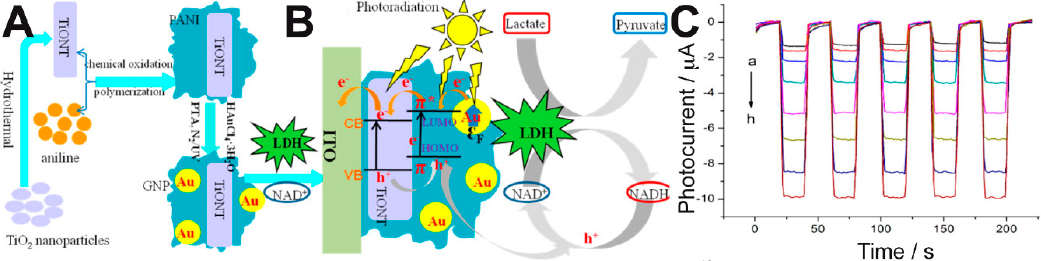
Figure 6. ( A ) Schematic of the preparation of TiO 2 nanotubes (TiONT)-polyaniline (PANI)-gold nanoparticles (GNPs) composites. ( B ) SPR-enhanced lactate biosensing mechanism of the TiONT-PANI-GNPs/lactate dehydrogenase (LDH)/nicotinamide adenine dinucleotide (NAD + )/ITO system comprising PEC cosubstrate regeneration. ( C ) Photocurrent response of the PEC biosensor in the presence of increasing concentrations of lactate. Adapted with permission from [78]. Copyright (2016) American Chemical Society.